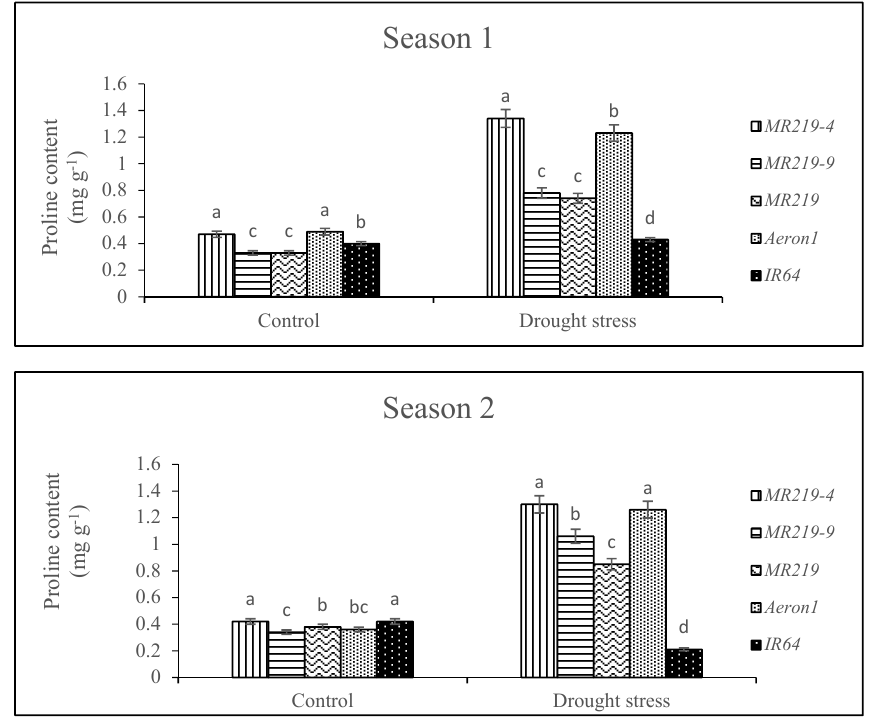
Figure 2. Effect of drought stress treatment on proline content in rice genotypes. Vertical bars represent ± standard error. Values within drought stress treatment with the different letter are significantly different based on comparison using DNMRT at p ≤ 0.05 ( n = 20).